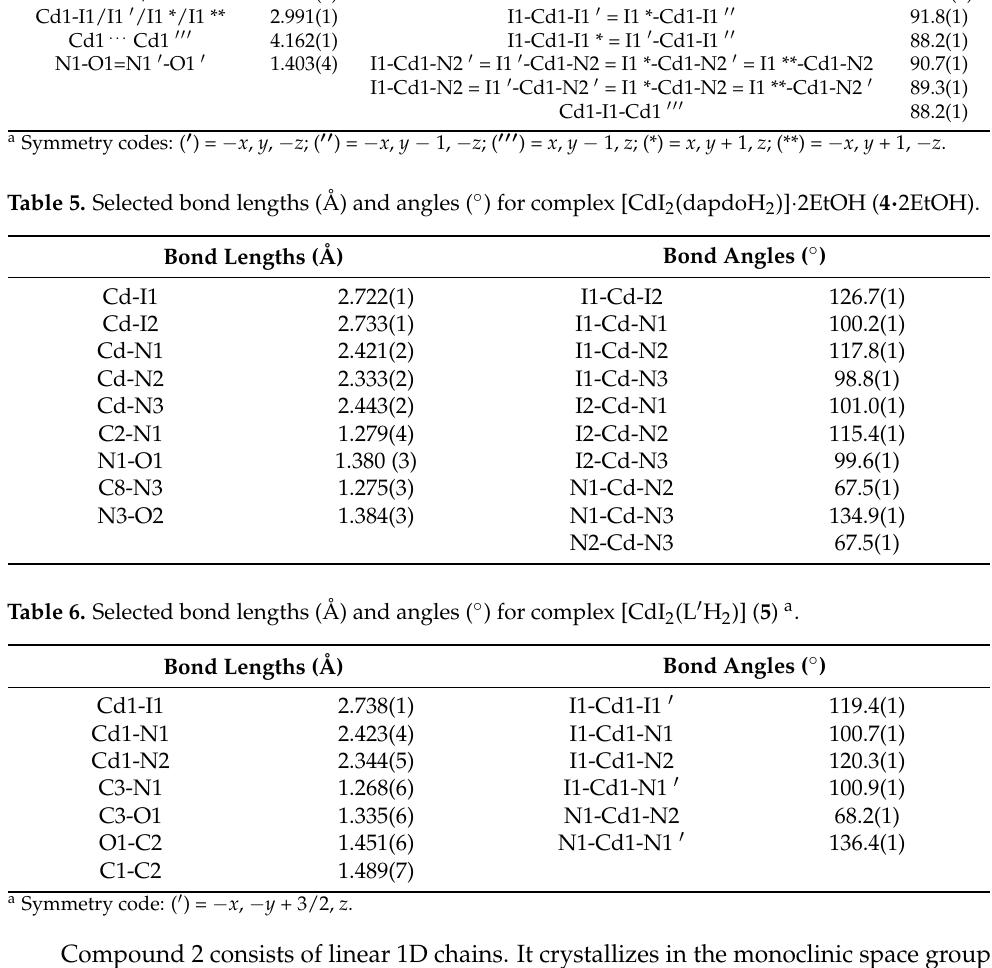
Compound 2 consists of linear 1D chains. It crystallizes in the monoclinic space group C 2/ m and the asymmetric unit contains 1 of the repeating unit [CdI 2 (3paoH) 2 ]. The Cd1 4 centers sit on Wyckoff positions 2a (0, 0.0, 0) with 2/ m point group symmetry, with the 2-fold axis being parallel to the b axis and the mirror plane cutting it at the y = 0.0 point. The atoms of the organic ligand are located on a mirror plane as all occupy the 4i ( x , 0.0, z ) Wyckoff positions with point group symmetry m . The I1 atoms are also located on 4i-type sites ( x , 0, y ) with a point group symmetry m , but in this case the mirror plane crosses the b axis at the y = 0.5 point. The Cd II and I atoms form chains parallel to the b axis and